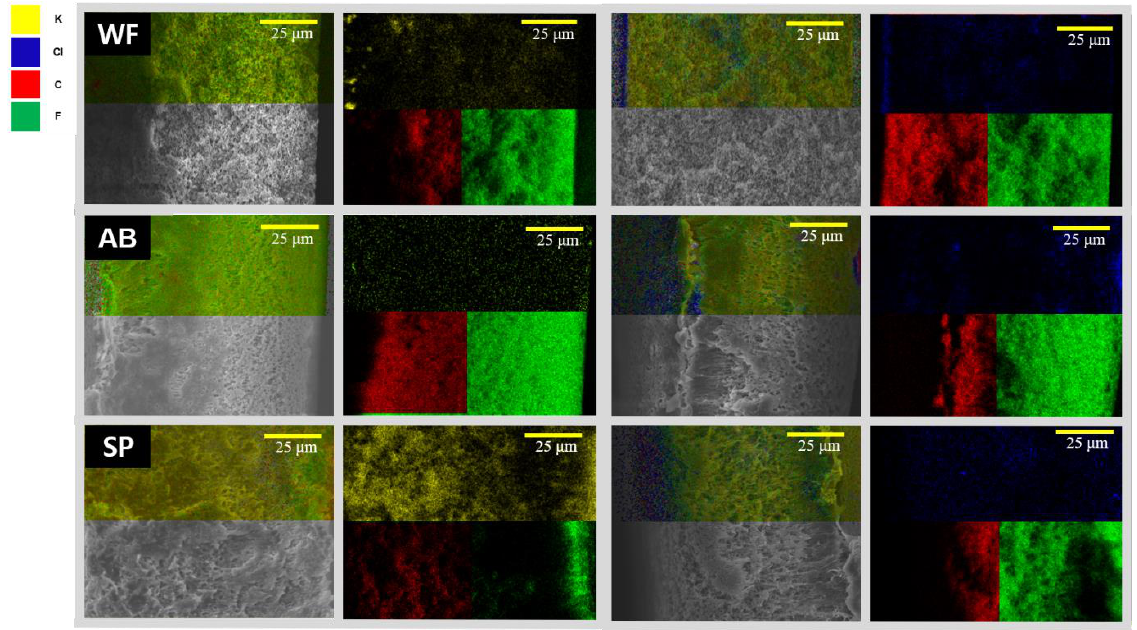
Figure 10. The SEM-EDS results of HCOOK and LiCl on a cross-sectional membrane with the cleaning method. WF: water flushing, AB: air back washing, and SP: membrane spacer.